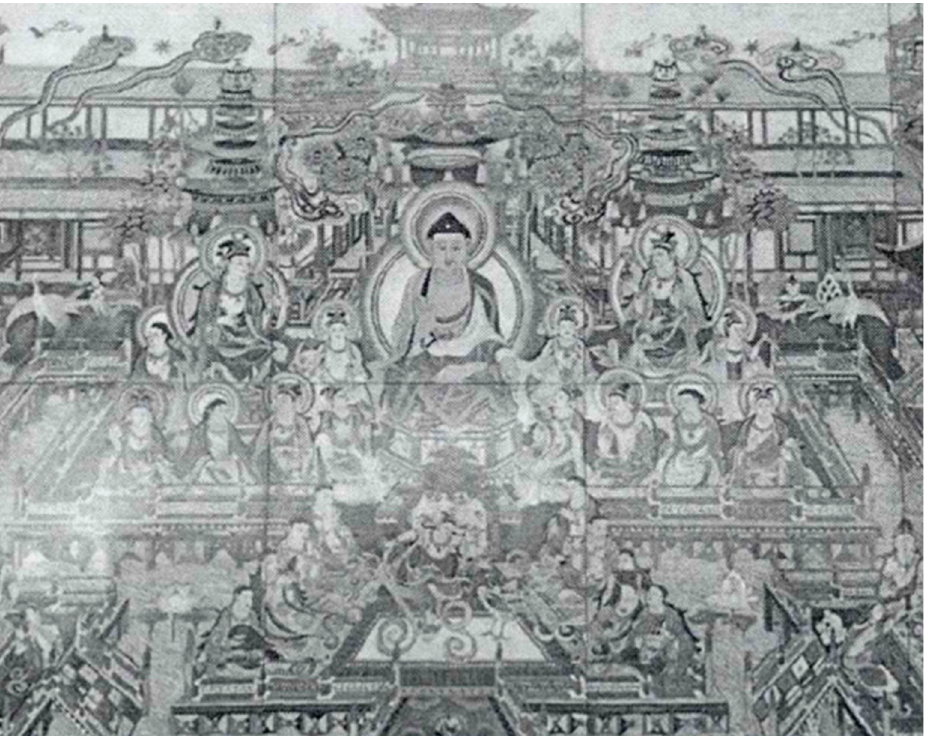
Figure 3. The variation of the Sutra of the Visualization of the Amit¯ayus S¯utra ( Fo shuo guan wuliangshou fo jing 佛 说 观 无 量 寿 佛 經 or Guan jing 觀 經 ) from Cave 25 of the Yulin 榆 林 Cave in the Mogao Caves at Dunhuang (Zhang 2018, p. 20).